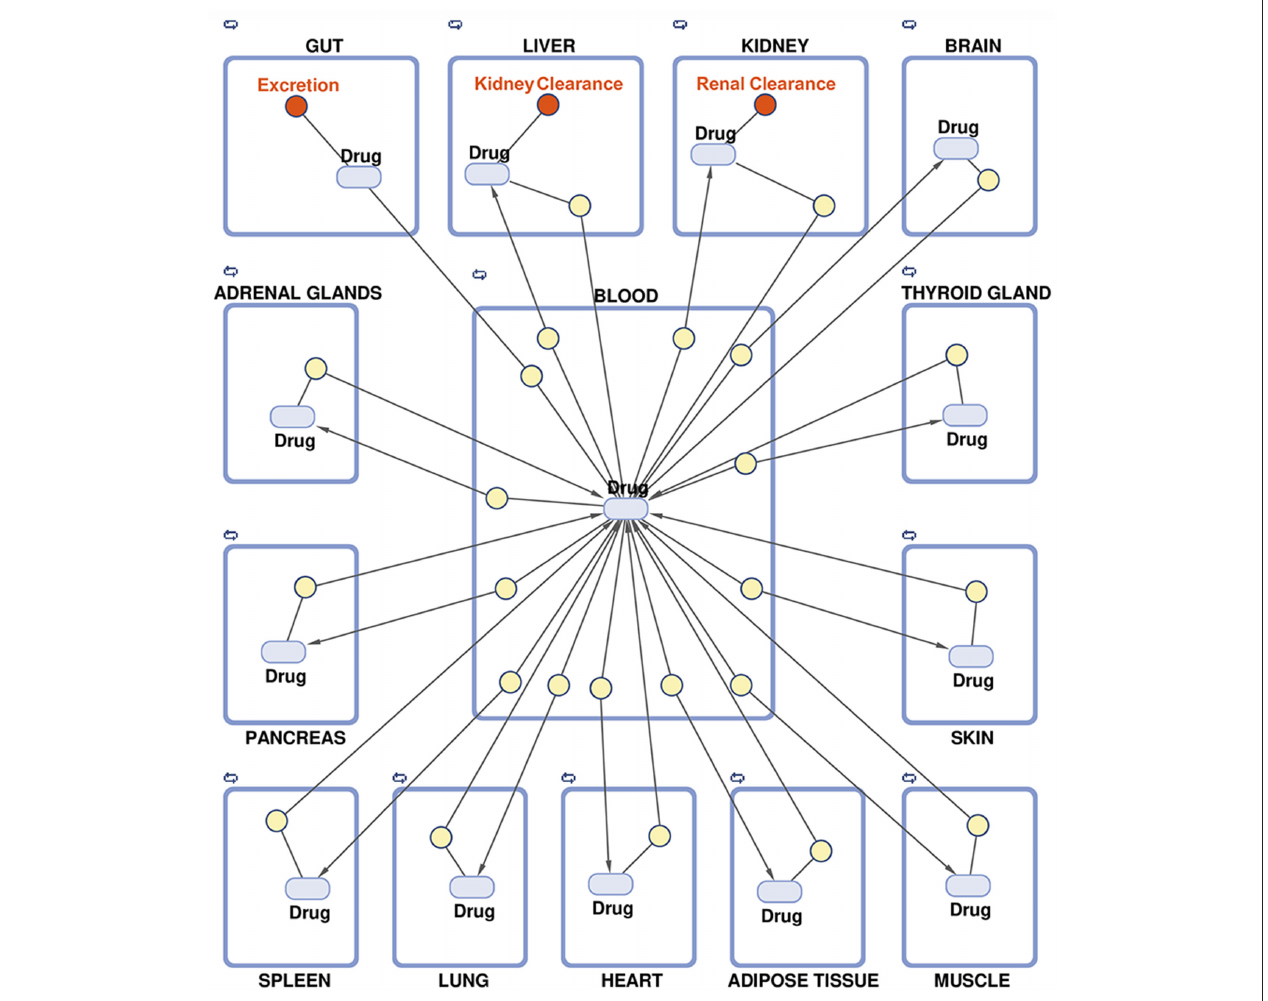
FIGURE 5 | Schematic representation of the multi-compartment model for physiologically based pharmacokinetic